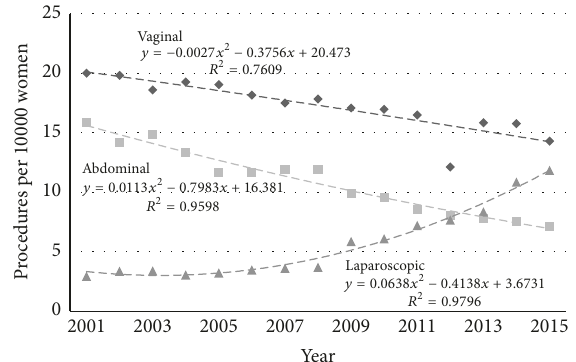
Figure 8: Percentage of all hysterectomies involving removal of the adnexae by age group (35 to 54 years, 55 to 74 years) for the period 2001 to 2015 in Australia. The epoch in which guidance advised possible opportunistic salpingectomy is